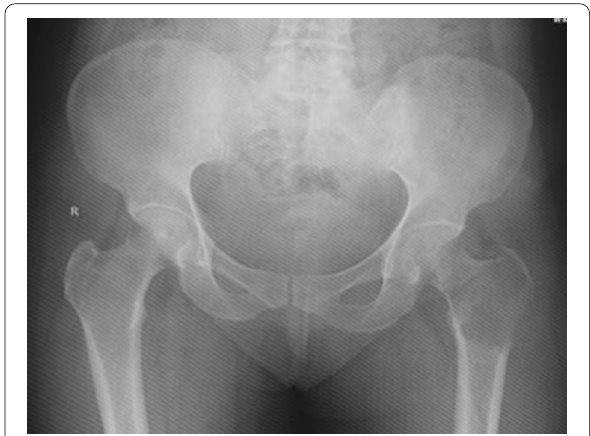
Fig. 1 X-ray: Adult skeleton showing an eccentric expansile lytic lesion in epiphysis of proximal left femur showing wide zone of transition, margins-IB/IC, no periosteal reaction, thinned out cortex. Pathological fracture of the neck of femur